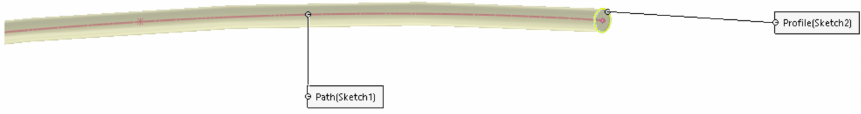
Figure 14. Defining the sweep shape.